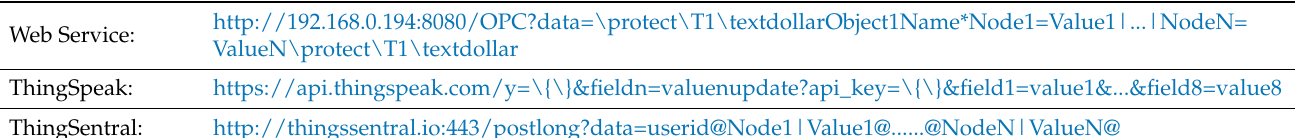
Table 3. Prescribed format to construct the web and cloud request.